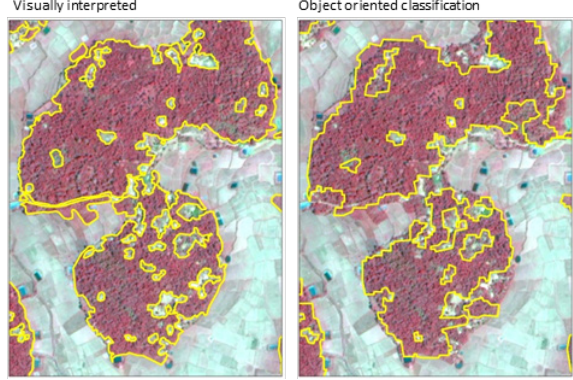
Figure-3: Comparison of coffee maps derived from visually interpreted and object based